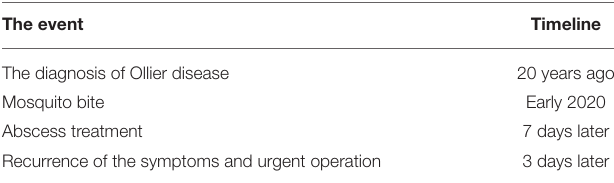
TABLE 1 | A table summarizing care checklist organized into a timeline. The